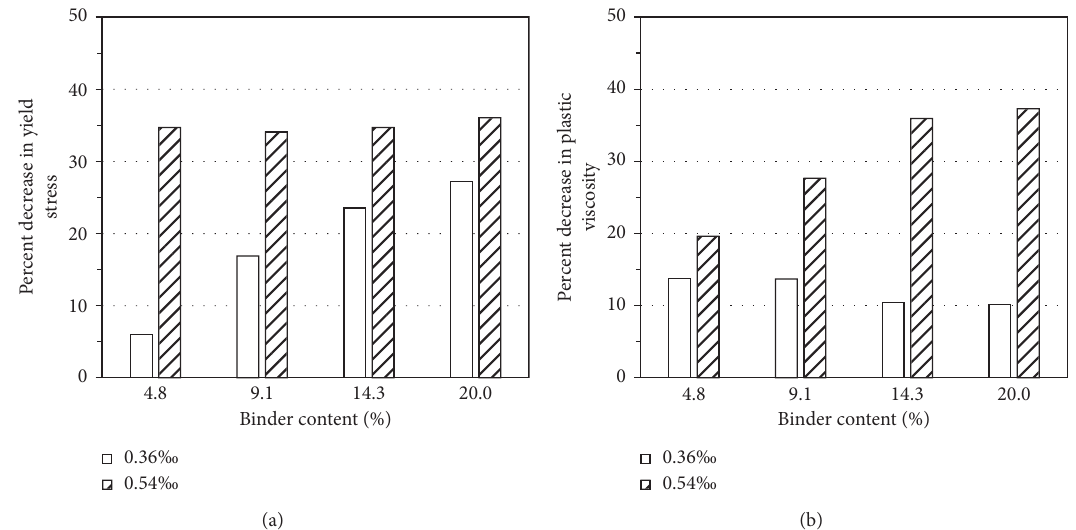
Figure 12: Effects of binder content and PC dosages on the percentage reduction of (a) yield stress and (b) plastic viscosity of